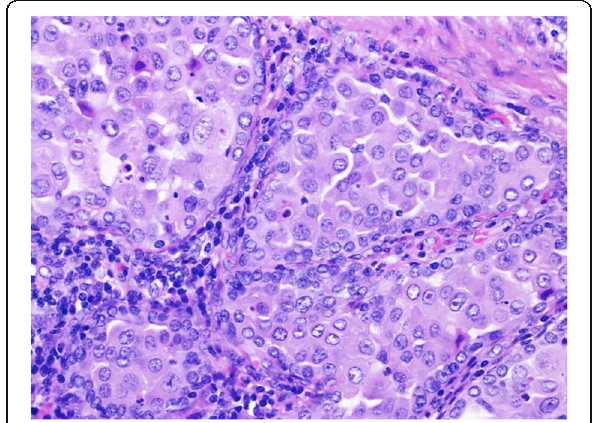
Fig. 8 Biphasic squamoid alveolar RCC. Aggregates of squamoid cell form a glomeruloid pattern with collarets of small lymphocyte-like